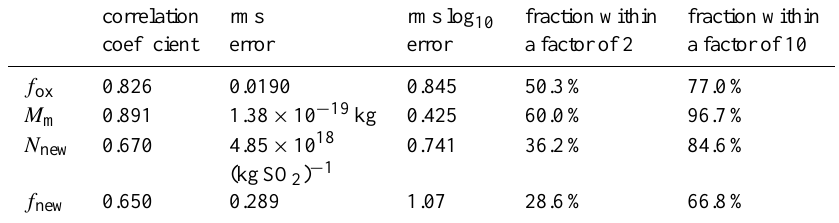
Table 6. Quality of fit information for the P6 parameterization predicted outputs and the results of SAM-TOMAS.